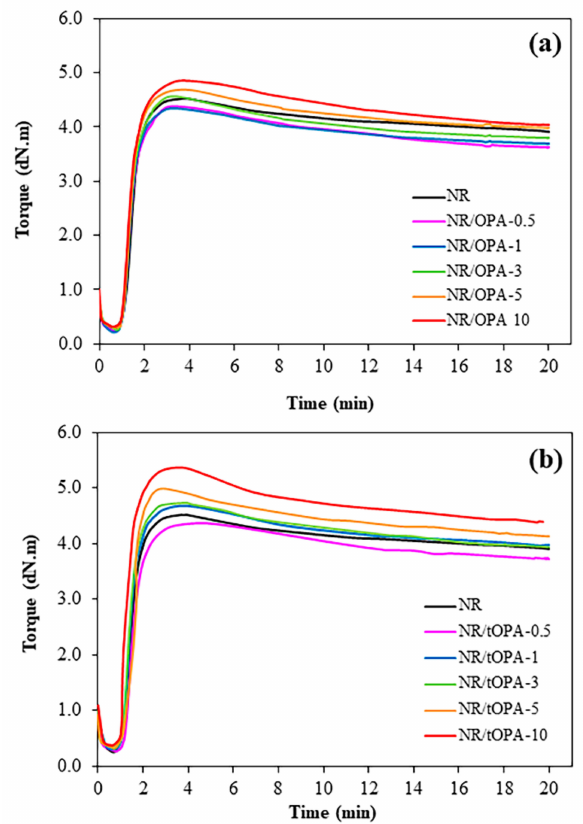
Figure 10. Cure curves of ( a ) NR/OPA and ( b ) NR/tOPA at various filler loadings. For cure kinetic of rubber, it was focused only on determination of vulcanization